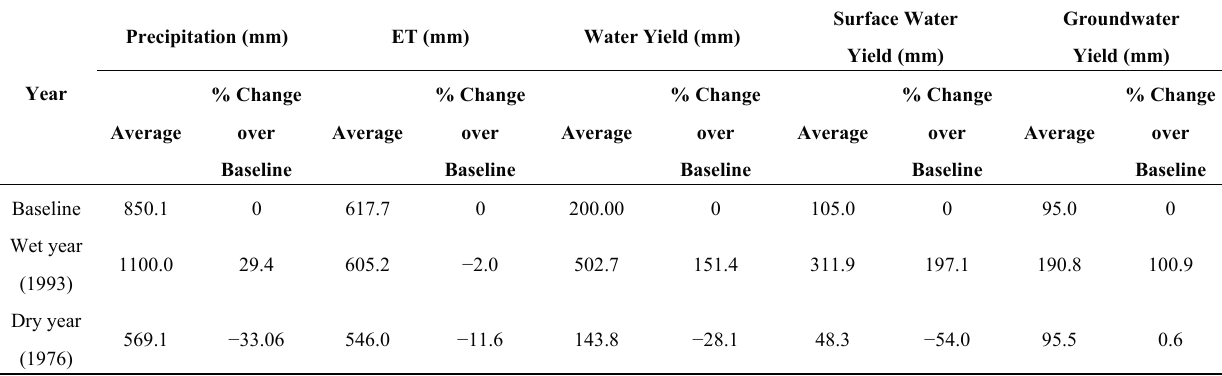
Figure 4. Spatial variation of corn yield (t/ha). Table 2. Comparison of Hydrologic Components between Baseline, Wet (1993) and Dry (1976) Years. ET =